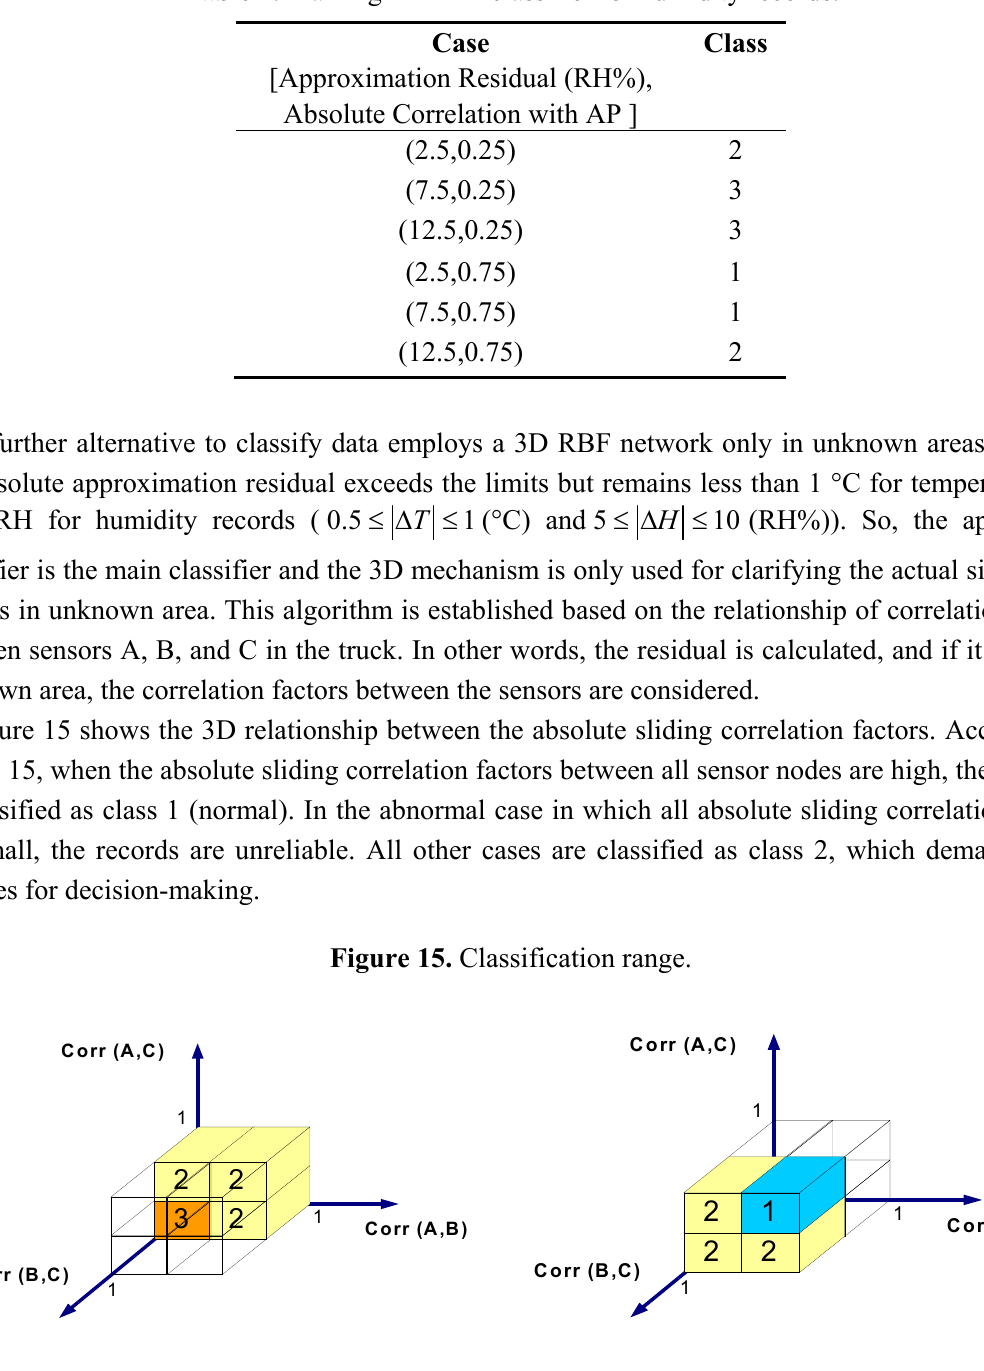
Table 2. Training 2D RBF classifier for humidity records.